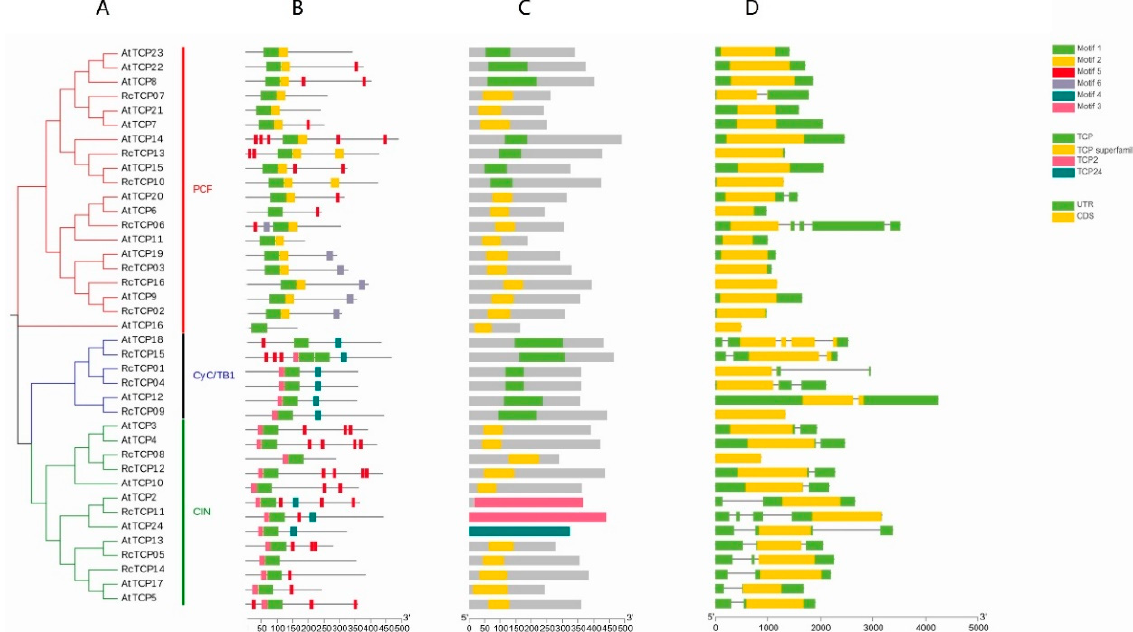
Figure 3. The phylogenetic relationships, distribution of conserved motif, domain prediction and gene structure analysis of Arabidopsis and R. chinensis TCP genes. ( A ) Phylogenetic tree of 23 Ara- bidopsis . TCP and 16 R. chinensis TCP genes. ( B ) Distribution of conserved motifs in TCP proteins. Six conservative motifs in TCP are displayed in different color boxes. ( C ) TCP domain of TCP proteins. This denoted the matching types that represent various confidence levels (specific matching, non-specific matching) and domain model ranges (superfamily, multi-domain). ( D ) TCP gene structures. The description of exons and introns adopts image tools. The green, yellow boxes and black lines represent the non-coding region (UTR), exon and intron, respectively.